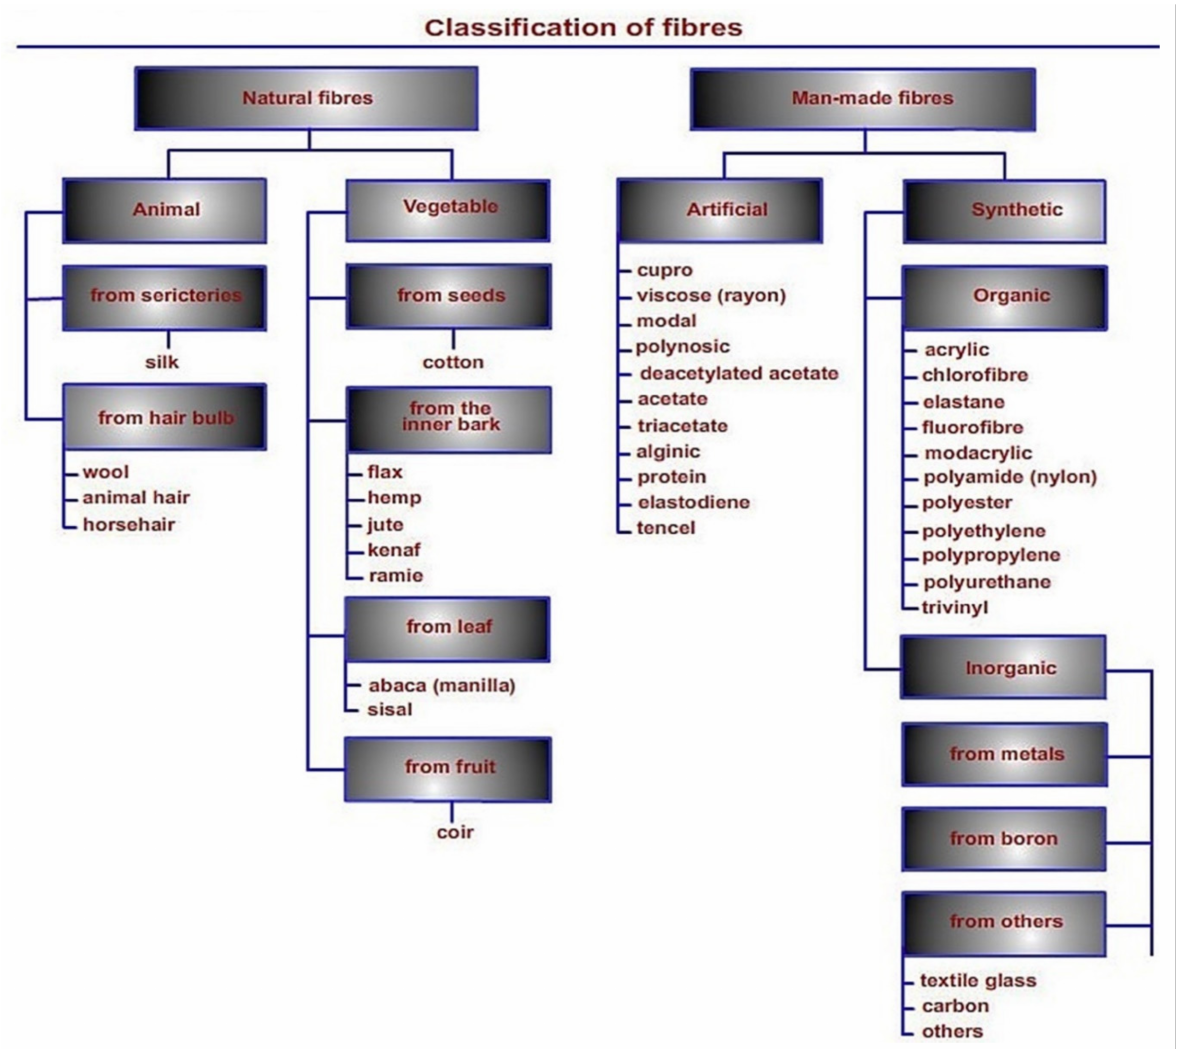
Figure 11. Classification of textile